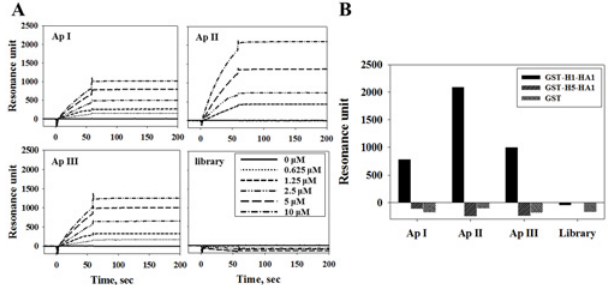
Fig 3. Affinity measurements of biotinylated ssDNA aptamers by SPR. (A) Biotinylated aptamers immobilized on an NLC sensor chip and interacting with various amounts of GST-H1-HA1. Equilibrium dissociation constants K D were calculated from association and dissociation rate constants (K D = k d /k a ) as 96.6 nM for ApI, 1.09 μ M for ApII, and 293 nM for ApIII. (B) Interaction of 10 μ M H1-HA1, H5-HA1, or GST with aptamers immobilized on an NLC sensor chip, as measured by